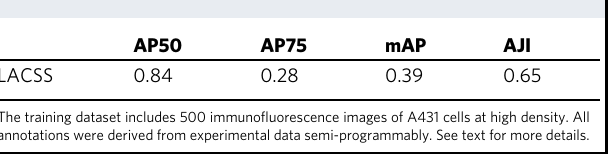
Fig. 7 LACSS model trained with semi-programmably generated annotations. a Examples of training data and accompanying annotations generated semi-programmably. b Examples of model inferences. The left panel shows the input fl uorescence image. The middle panels show the comparison of input image and the model predictions (yellow contours). The right panel shows the comparison of model prediction (white contour) with manual segmentation (color map). The bottom example represented a more challenging case with atypical image contrasts. Scale bars represent 20 Table 3 Benchmarking LACSS models trained with A431 image data and annotations.